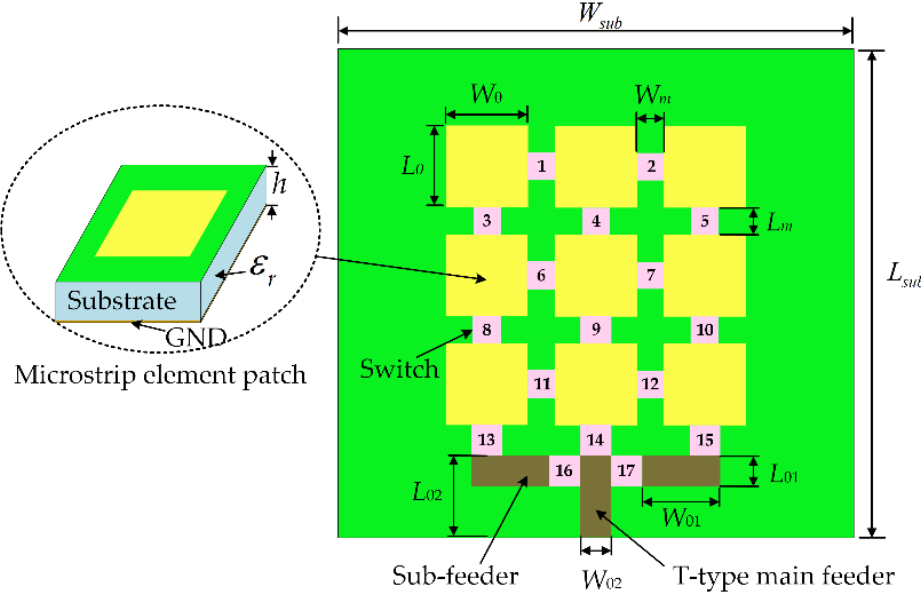
Figure 1. Schematic of a reconfigurable microstrip antenna. Table 1. Antenna structural parameters.